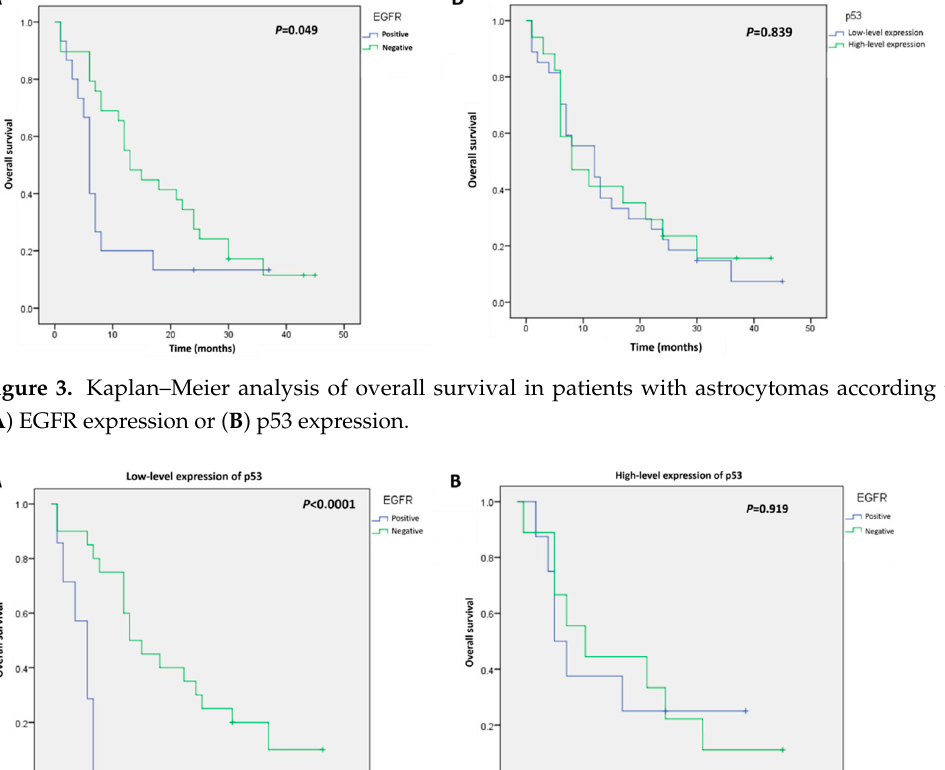
Figure 2. Immunohistochemical staining for EGFR in astrocytomas. ( A ) Astrocytoma with strong EGFR expression in a patient with glioblastoma. ( B ) Astrocytoma with weak EGFR expression in a patient with grade III tumor (100×). Table 1. Correlation of p53/EGFR expression with clinicopathologic parameters in astrocytomas.